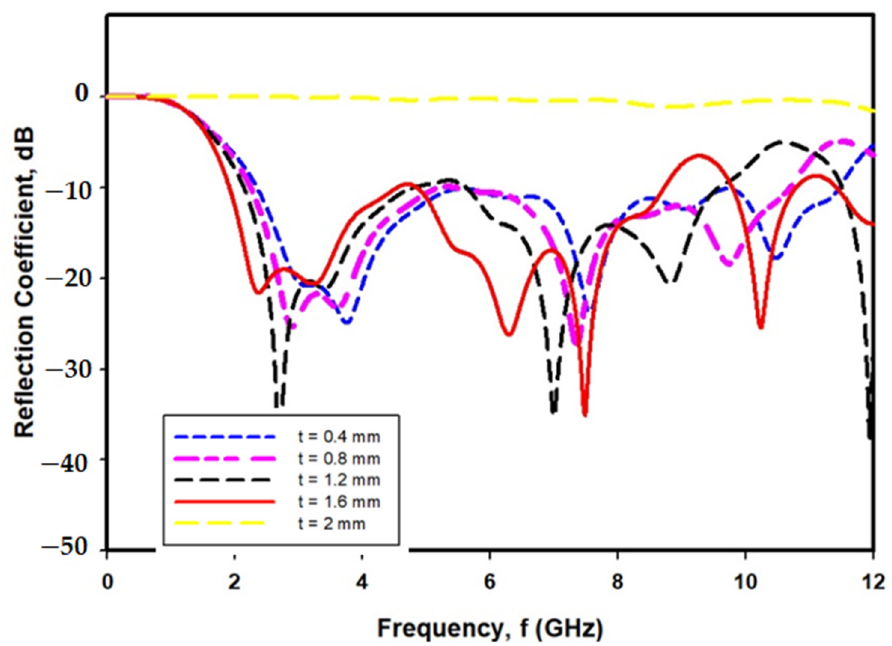
Figure 8. Operated bandwidth for Magnetite − PDMS Graphene Array sensor with different thickness of substrate.